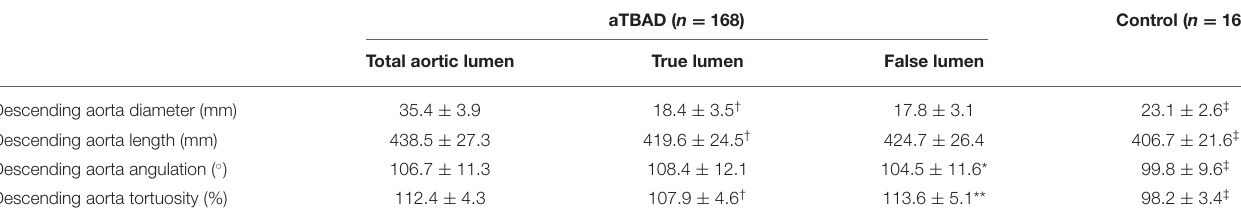
TABLE 3 | Geometric variables of the descending aorta in the aTBAD and control